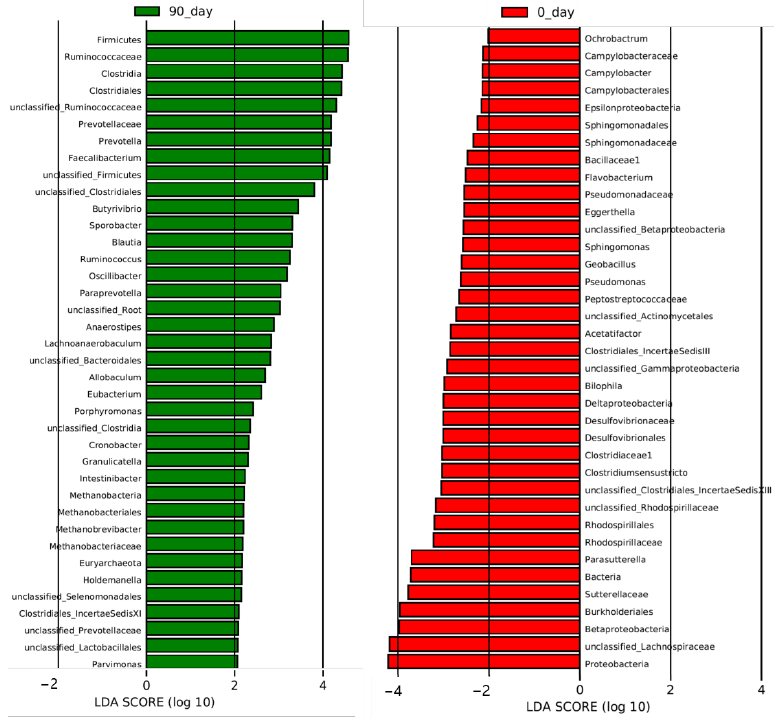
Figure 5. Effect of sea buckthorn berries puree on plasma metabolites in hypercholesterolemia population. From phylum to Genus. The results of LEfSe (LDA Effect Size) analysis level at week8. The histogram of LDA score generated from LEfSe analysis showed the differentially abundant species (the absolute value of LDA greater than 2) after the treatment of sea buckthorn berries puree. The length of the bars (LDA Score) represents the influencing degree of the species. The species with positive or negative LDA score have higher or lower abundance after the treatment. n = 48, each group.